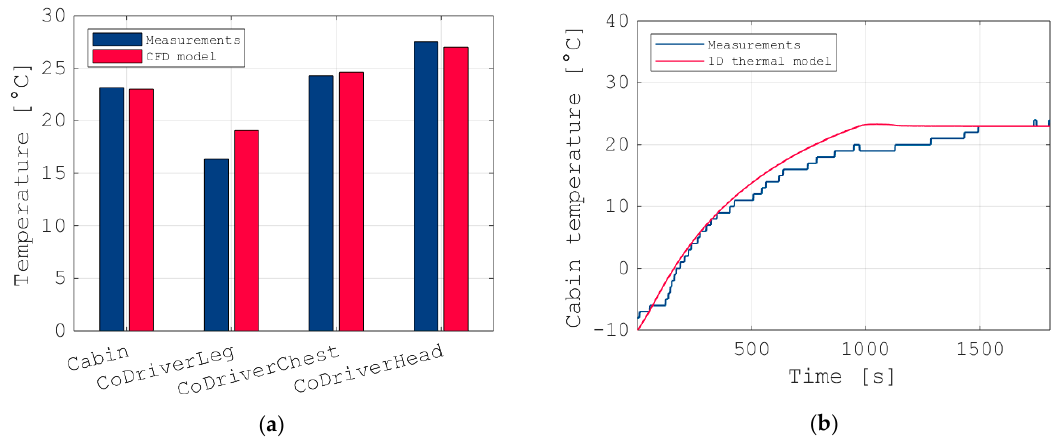
Figure 9. One-dimensional thermal model validation: ( a ) the steady state conditions; and ( b ) transient